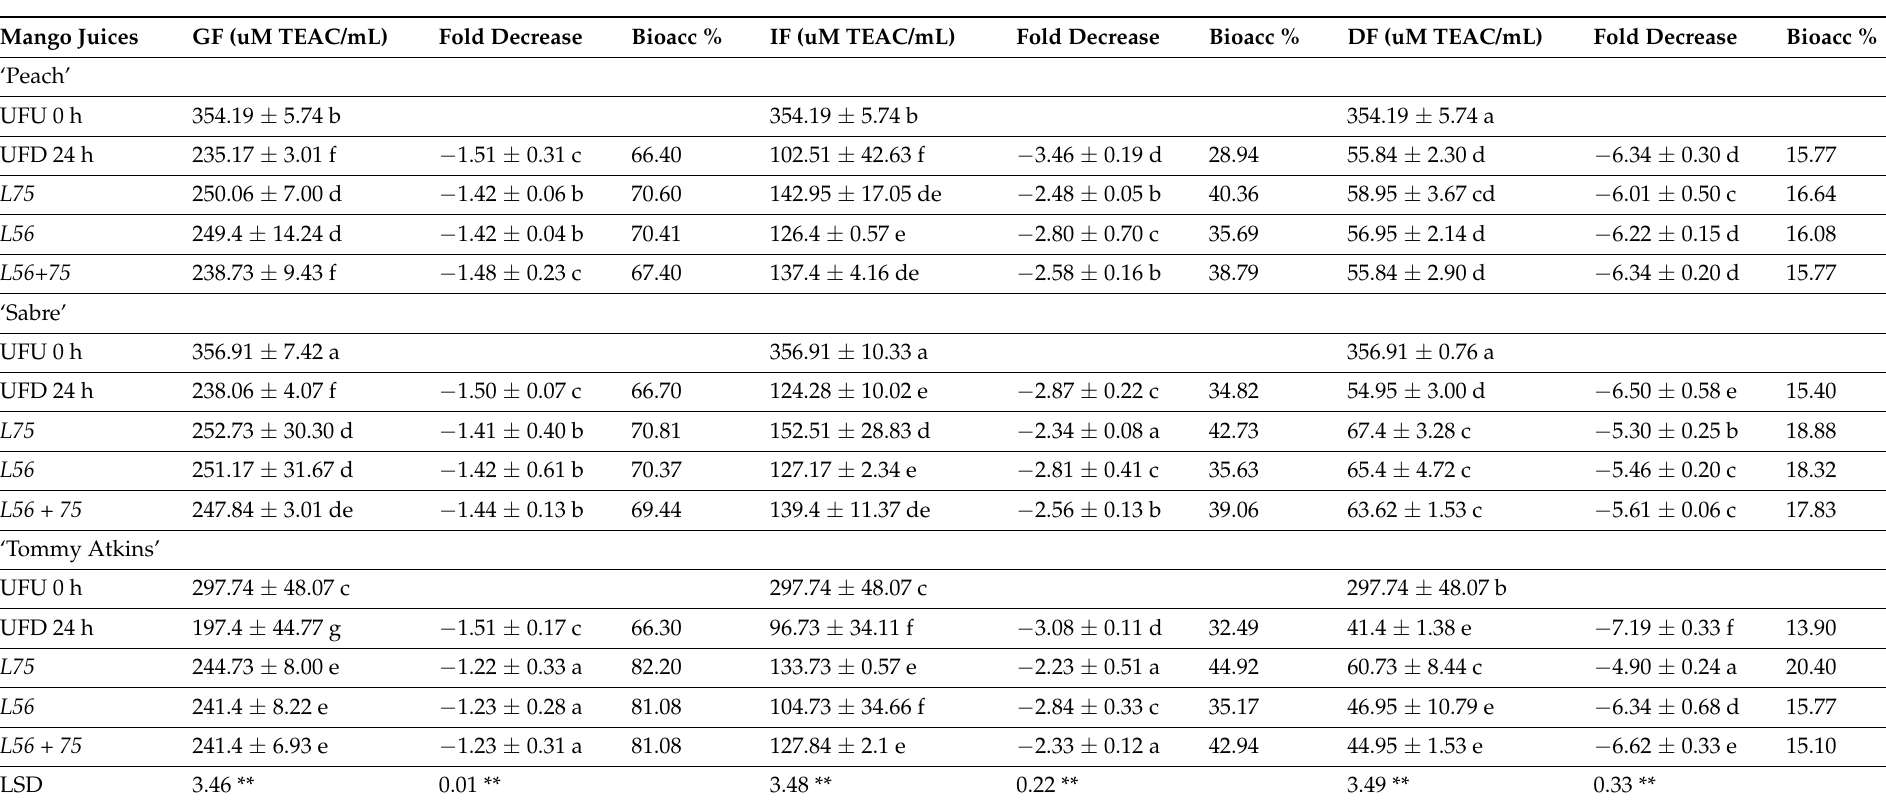
Table 3. Antioxidant power (FRAP) of MJs of different cultivars fermented with LAB after in vitro GI digestion. Mango